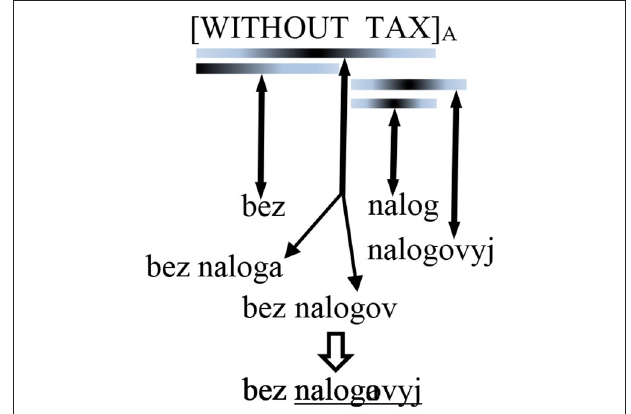
FIGURE 4 | Larger units being blended together to produce nalogovyj